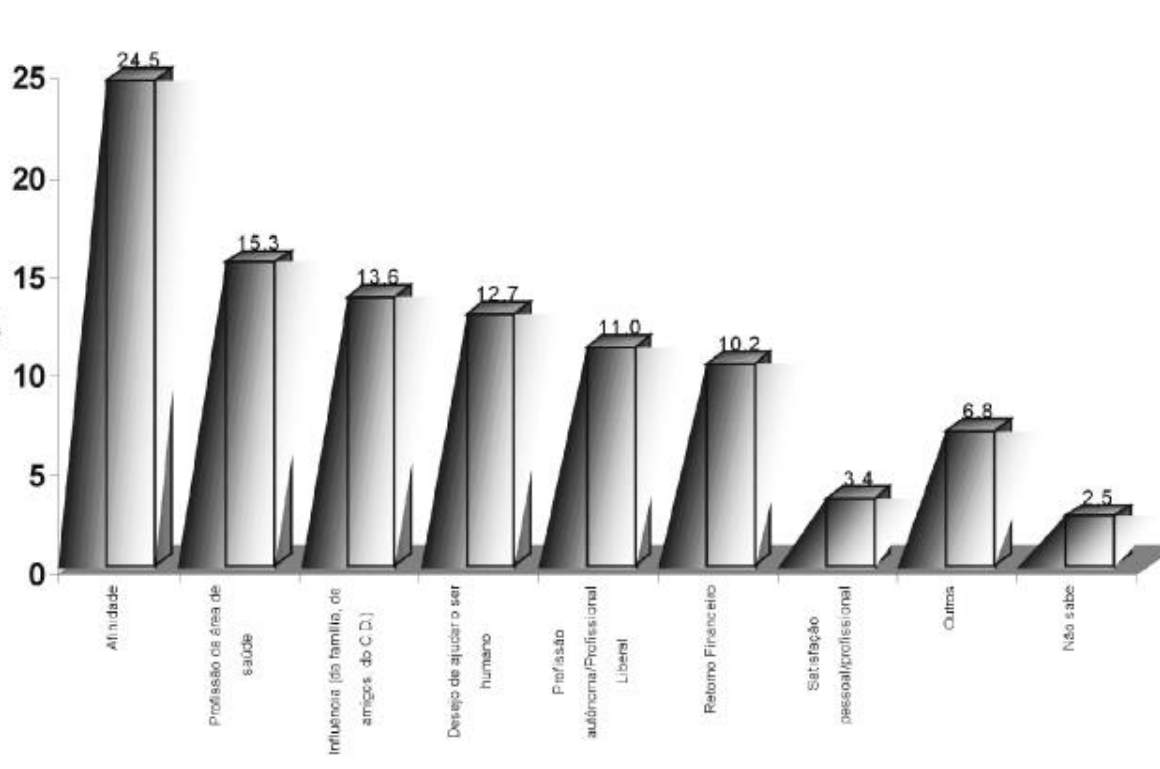
FIGURA 1- Motivos que levaram os profissionais a escolher a Odontologia como profissão